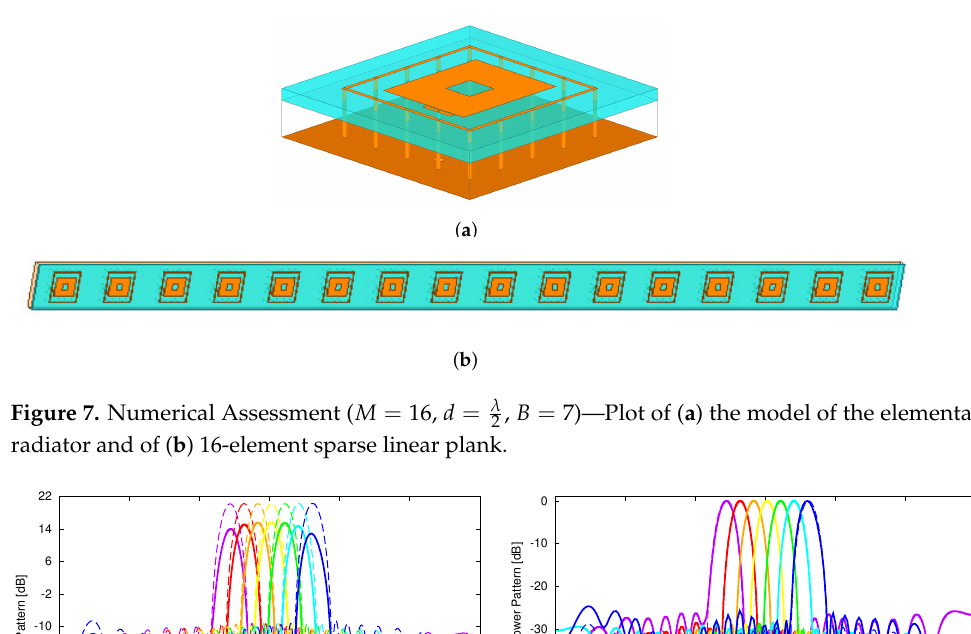
, B = 7)—Plot of ( a ) the model of the elementary 2